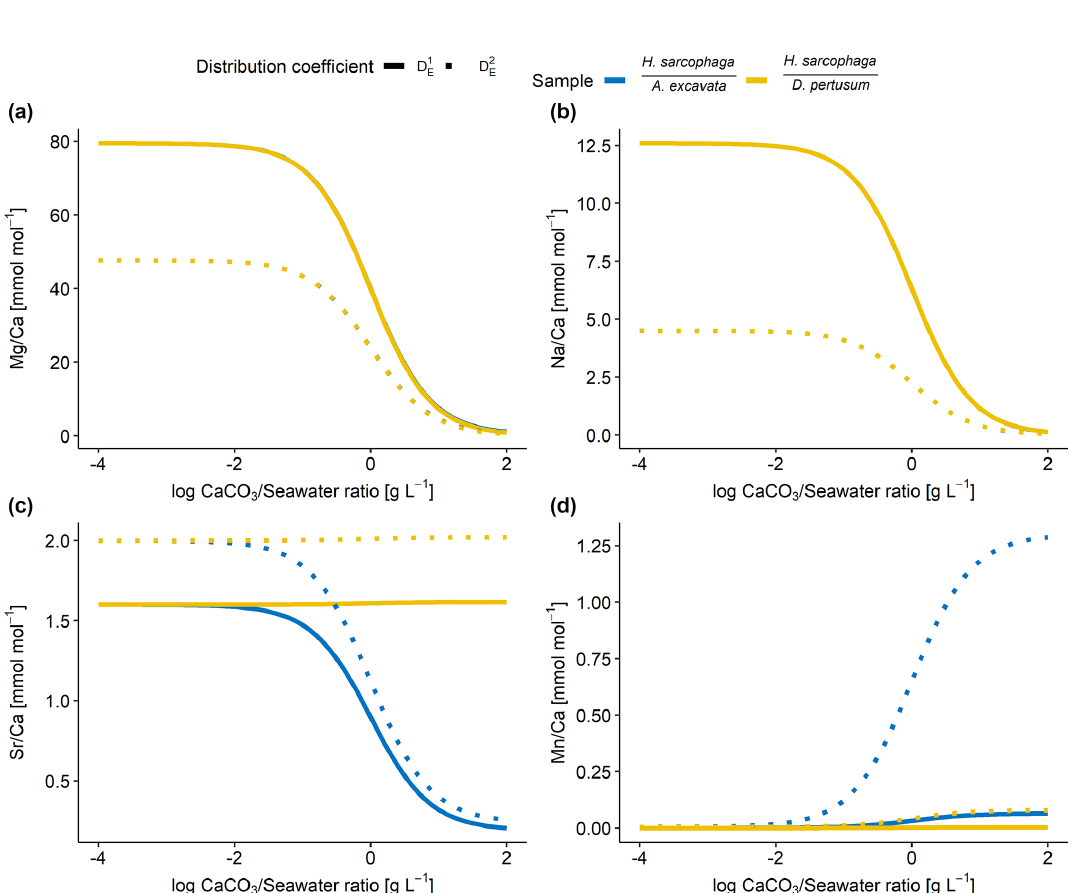
Figure 7. Results of model calculations with the parameters listed in Table 4 for the measured E / Ca ratios. Text below the horizontal lines in the legend is the host organism that H. sarcophaga grew on. Independently of the mixing ratio of dissolved host CaCO 3 and ambient water, no differences of the geochemical signature are predictable in Mg / Ca and Na / Ca. On the contrary, Sr / Ca and Mn / Ca ratios are predicted to diverge at mixing ratios > 0.01g CaCO 3 L − 1 seawater. Solid lines are produced with D 1 are produced with D 2 for the calculation (see Table 4). In panels (a) and (b) , the different samples overlap each E